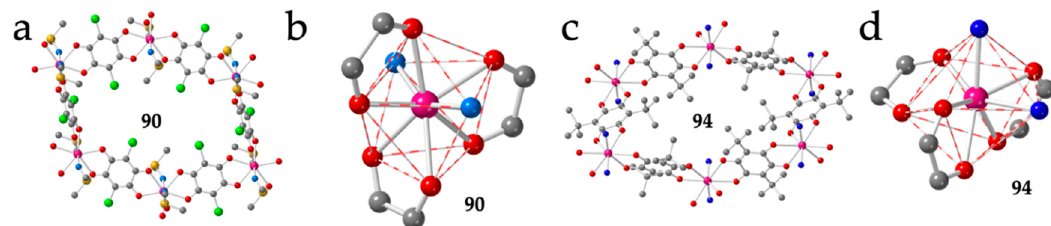
Figure 11. ( a ) View of a distorted hexagonal ring in compound 90 showing the four FO and two EO anilato rings. ( b ) View of the coordination environment of the Er(III) ion in compound 90 . ( c ) View of a distorted hexagonal ring in compound 94 with four FO and two EO anilato rings. ( d ) View of the coordination environment of the Nd ion in compound 94 . Colour code: Ln = pink, C = grey, O anilato = red, Cl = green, S = yellow and O solvent = blue.